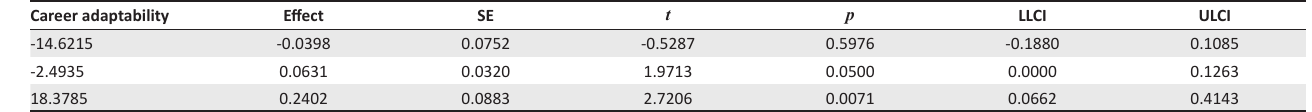
TABLE 9: Conditional effects of the focal predictor at values of the moderator(s)/Johnson–Neyman significance region(s). Career